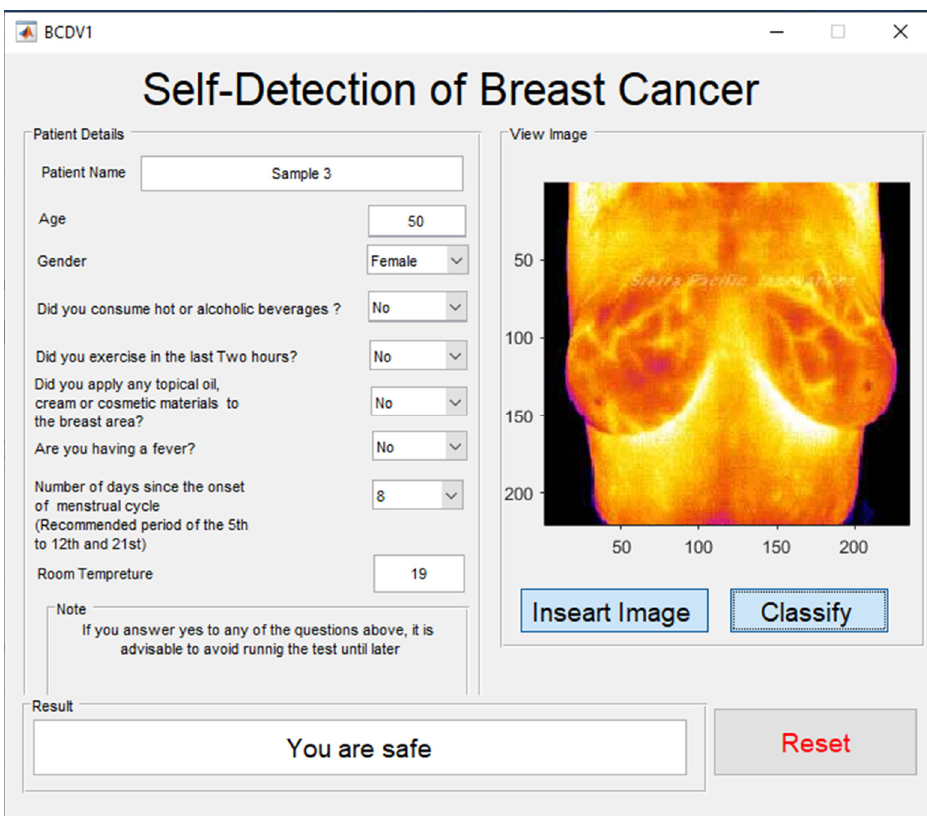
Figure 8. A GUIDE for BCD.